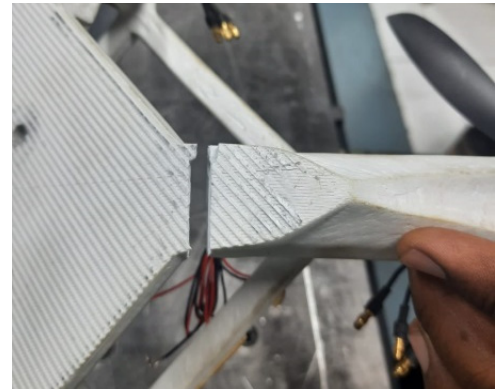
Figure 17. Failure at first natural frequency.